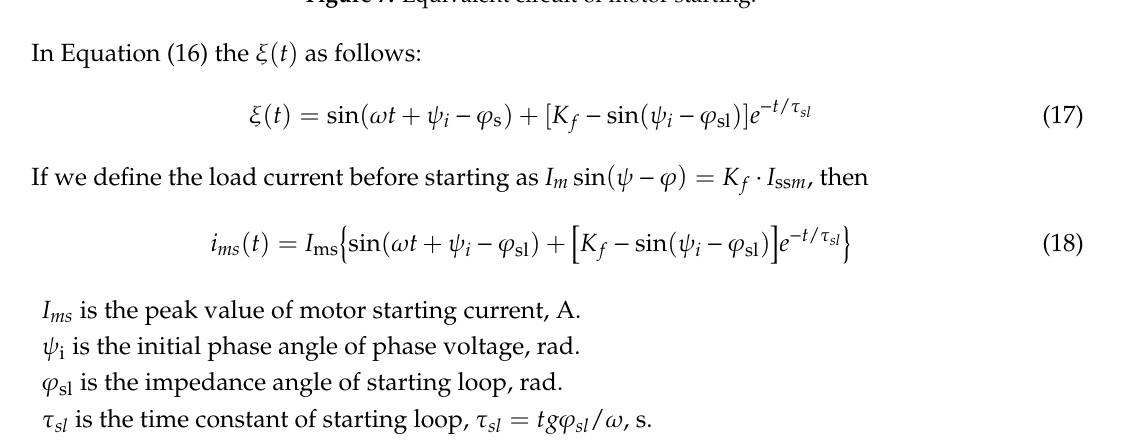
Figure 7. Equivalent circuit of motor starting.